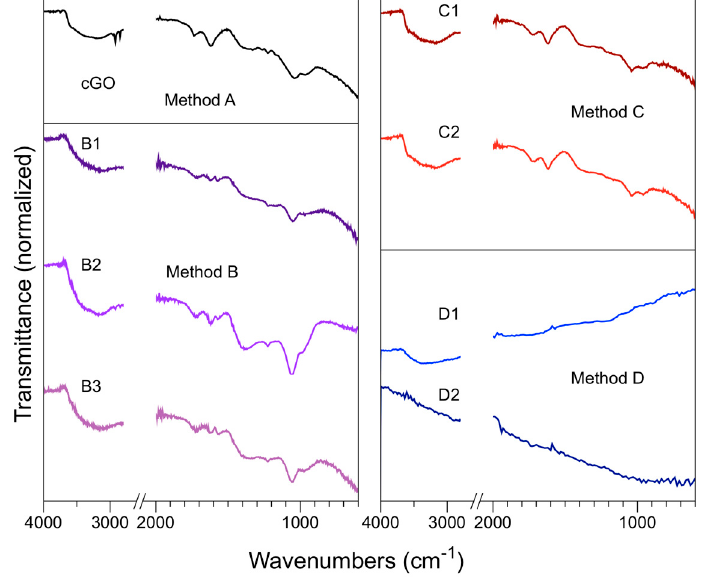
Figure 5. FTIR spectrum of method A (cGO), method B (B1, B2, B3), method C (C1, C2), and method D (D1, D2).